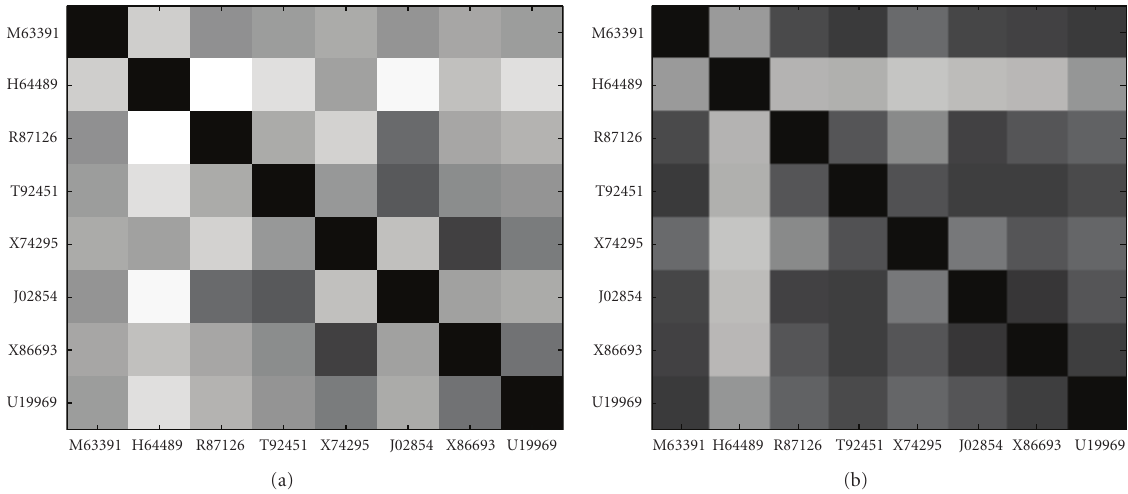
Figure 7: Images of the Euclidean distance matrices for the eight genes from colon dataset. (a) Normal samples. (b) Disease samples.